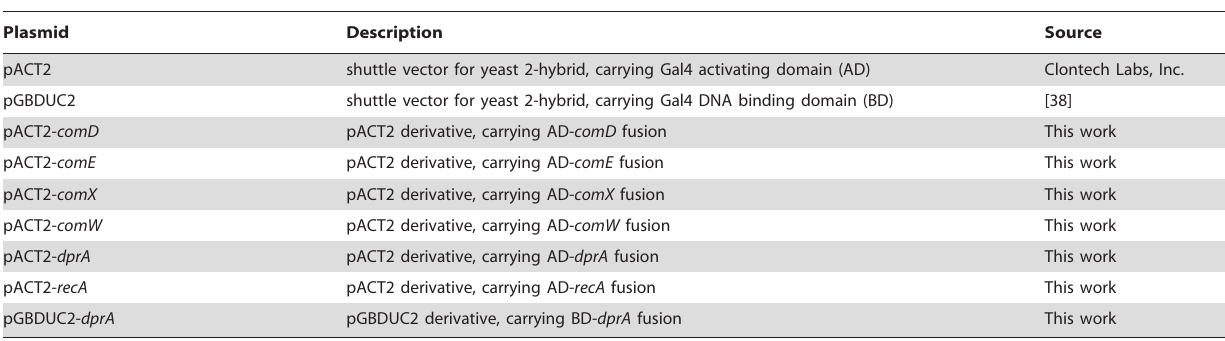
Table 3. Plasmids used in this studies.